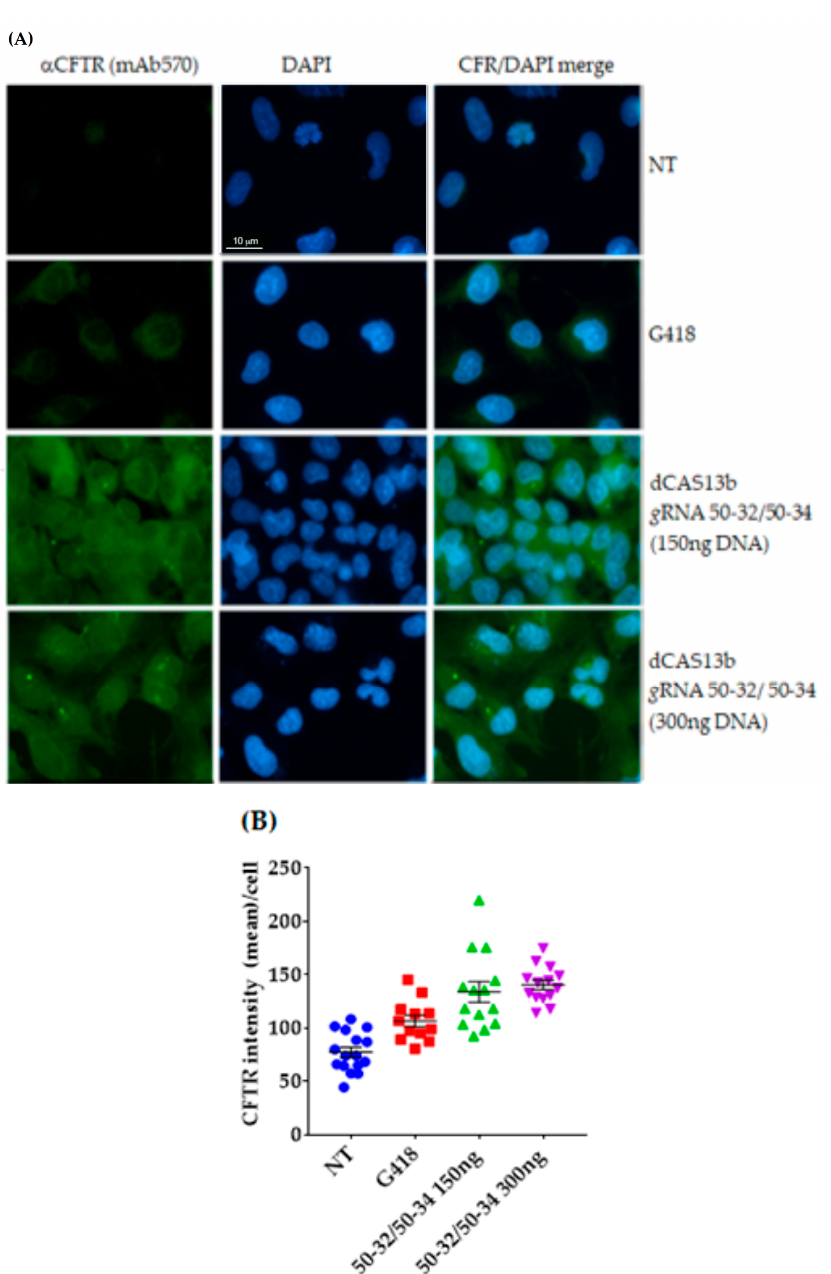
Figure 8. Immunofluorescence analysis to detect the CFTR protein in triton permeabilized IB3-1 cells and quantification of the immunofluorescence. IB3-1 cells were untreated (NT: Negative control), treated with G418 (positive control), or transfected with the plasmids encoding the 50-32 / 5034 g RNAs and dCAS13b / ADAR2 DD . ( A ) CFTR protein was revealed by the specific primary antibody mAb570 and a secondary antibody (green, Alexa-488, Abcam). Nuclei (blue) were DAPI stained. Images were taken at 63x magnification on a ZEISS microscope equipped for epifluorescence. ( B ) The quantification is relative to the replicate representative of the results. The error bar represents the SEM. The quantification of CFTR signal was done manually by using Fiji software. The cell contour was drawn by using a cell membrane marker. The background was subtracted and the pixel mean in the selected area (one cell) was measured.